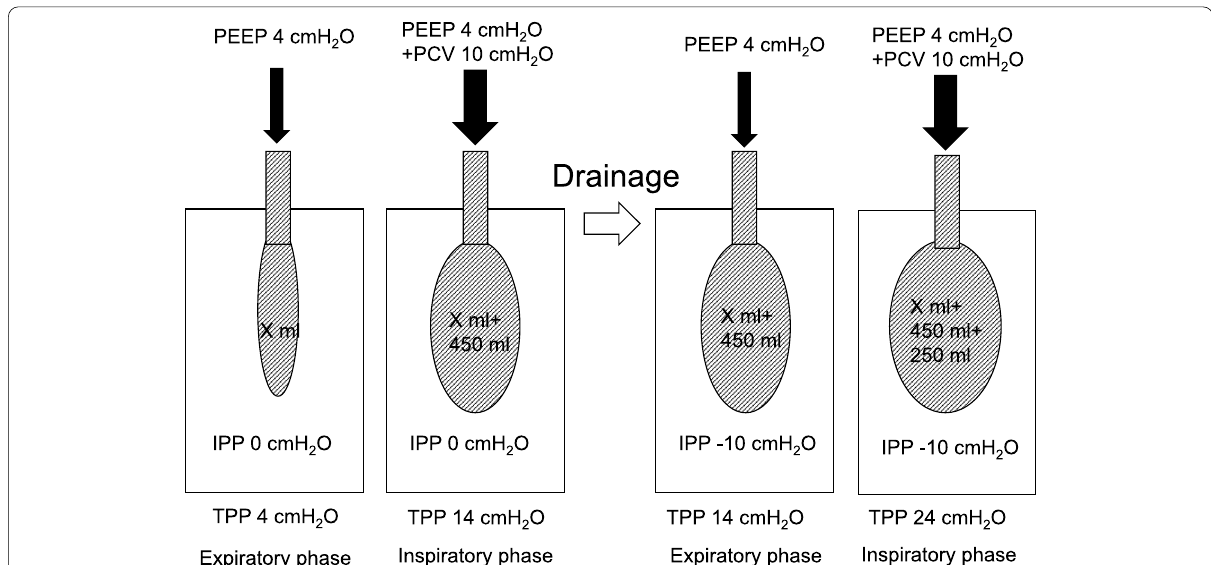
Fig. 2 The phenomenon happened after drainage. The left side of the figure shows the lung state during PCV without drainage. The right side of the figure shows the lung state under PCV after starting drainage. After drainage of – 10 cmH 2 O, TPP became 14 cmH 2 O at the expiratory phase, which would have generated X 450 ml of residual volume. Here, 10 cmH 2 O of driving pressure increased TPP to 24 cmH 2 O but only generated + 250 ml of TV probably because of increased elastance by overextension of the lung. PEEP, positive end-expiratory pressure; Plateau Prs, plateau pressure; PCV , pressure control ventilation; VCV , volume control ventilation; IPP , intrapleural pressure; TPP , transpulmonary